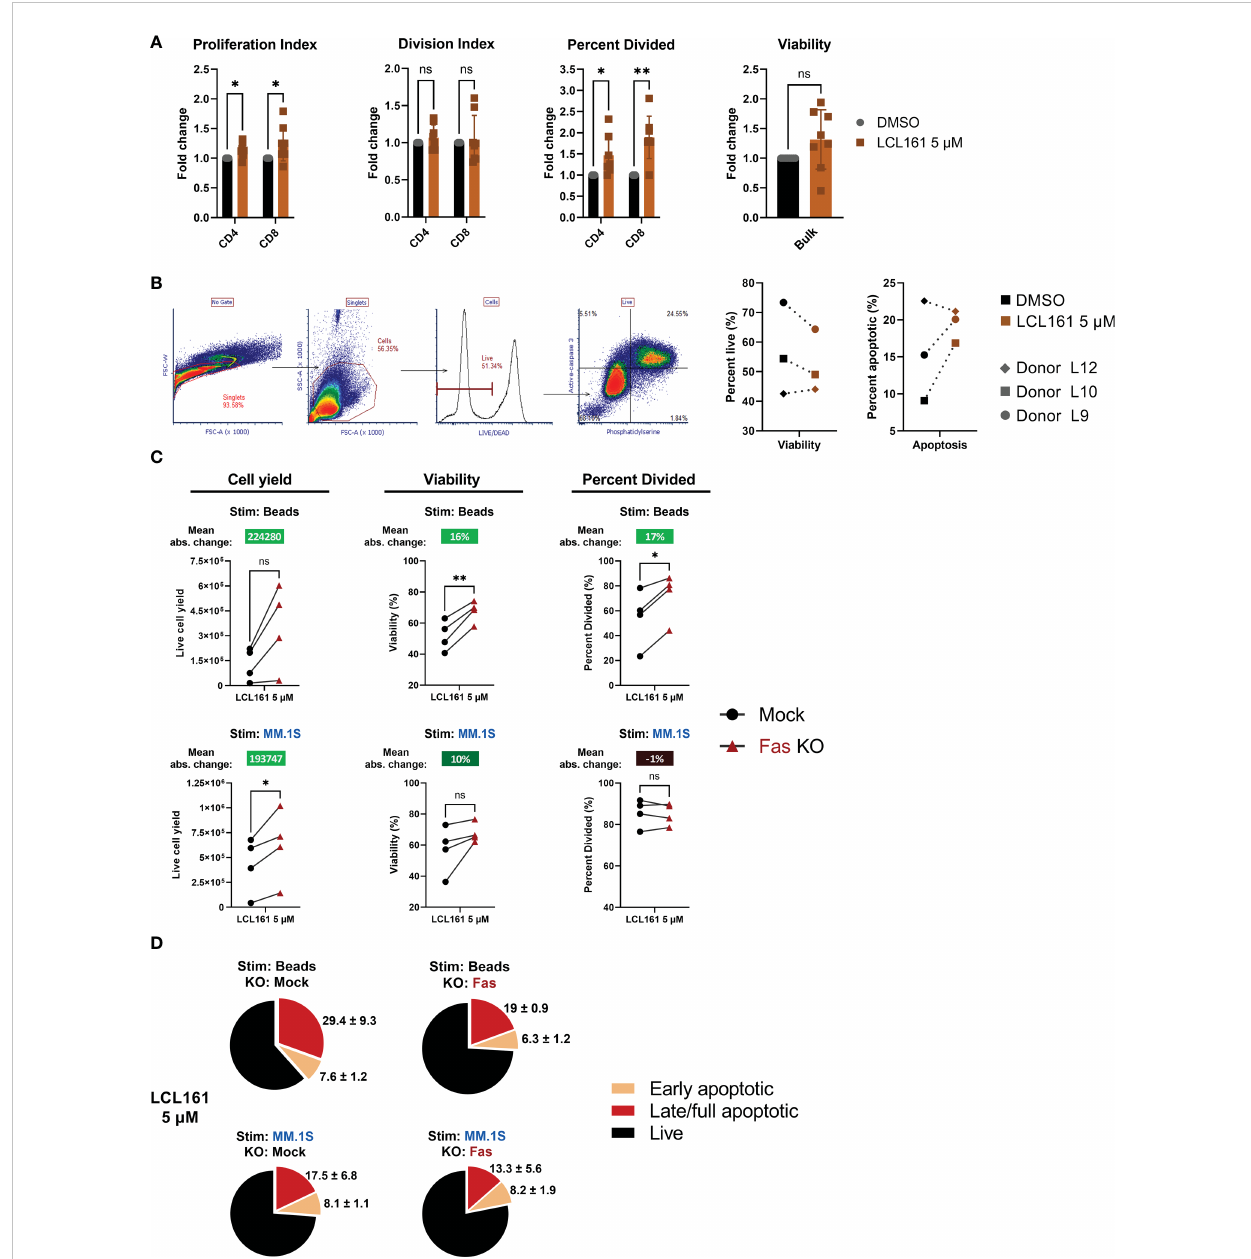
FIGURE 6 High dose LCL161 initiates activation induced cell death in stimulated TAC T cells that is responsive to Fas KO only in the case of antigen-alone stimulation. (A) TAC T cells labeled with CellTrace Violet were cultured with loaded beads at an E:T of 1:1 for 96 hrs. T cells were harvested and stained for fl ow cytometric analysis. Proliferation metrics were modeled with FCS Express 7. Proliferation and division indices are a measure of the average number of cells any or a dividing cell generates, respectively. Paired and unpaired parametric t tests with Holm-S ̌ ı ́ da ́ k correction was used to calculate statistical signi fi cance; ns, P>0.05, *P<=0.05, **P<= 0.01. n=8, comprising 5 different donors generated in 7 independent experiments (B) TAC T cells were stimulated with protein G polystyrene beads coated with antigen-loaded microbeads for 48 hrs. Viability and proportion of apoptotic cells as de fi ned by live/dead, phosphatidylserine and active-caspase 3 staining. Viable cells are de fi ned as live/dead negative, and apoptotic cells de fi ned as active caspase3 + and PS + . Data represent T cell products from 3 donors produced in 3 independent experiments. (C) CTV-labeled mock or Fas-edited TAC T cells stimulated 1:1 with MM.1S tumor cells or BCMA-coated microbeads and in the presence of 5 m M LCL161 or vehicle for 96 hrs. After stimulation, samples were stained, mixed with counting beads, and analyzed by fl ow cytometry. Proliferation metrics were modeled using FCS Express 7 software. Mean absolute change between mock and Fas KO is reported above each condition. Data were generated with T cells from 4 donors (L15, M12, M28, M46) produced in 3 independent experiments. (D) Mock or Fas-edited TAC T cells were stimulated 1:1 with MM.1S tumor cells or BCMA-coated microbeads and in the presence of 5 m M LCL161 or vehicle for 72 hrs. After stimulation, cells were stained for live/dead, fi xed, and fi nally stained for phosphatidylserine. Cells were analyzed by fl ow cytometry. Early apoptotic cells were de fi ned as live/dead - , PS + , late/full apoptotic cells were de fi ned as live/dead + , PS + . Pie charts represent mean values, with mean + SD written outside the pie slice. Data were generated with T cells from 3 donors (M12, M28, M46) produced in 2 independent